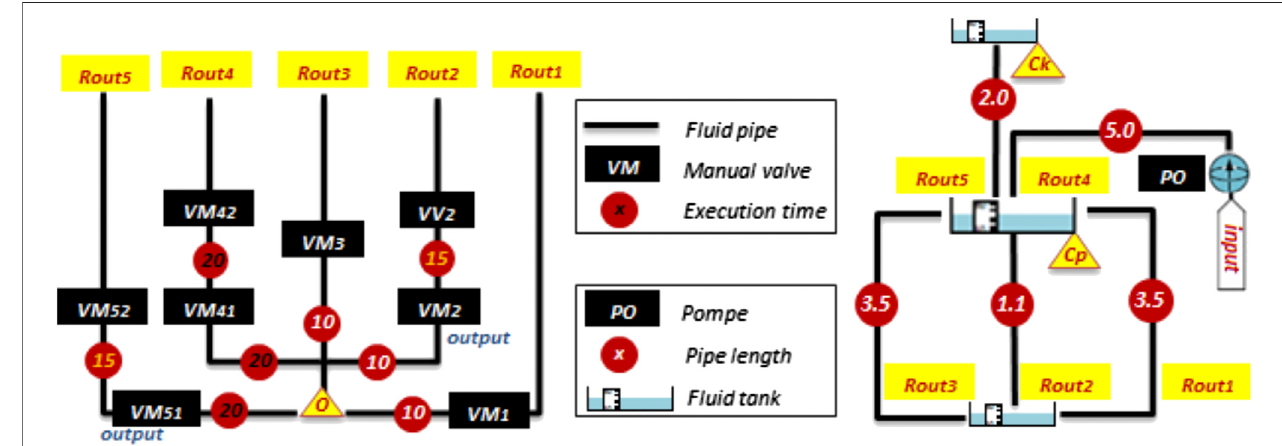
FIGURE 8 | Execution time and pipe length.